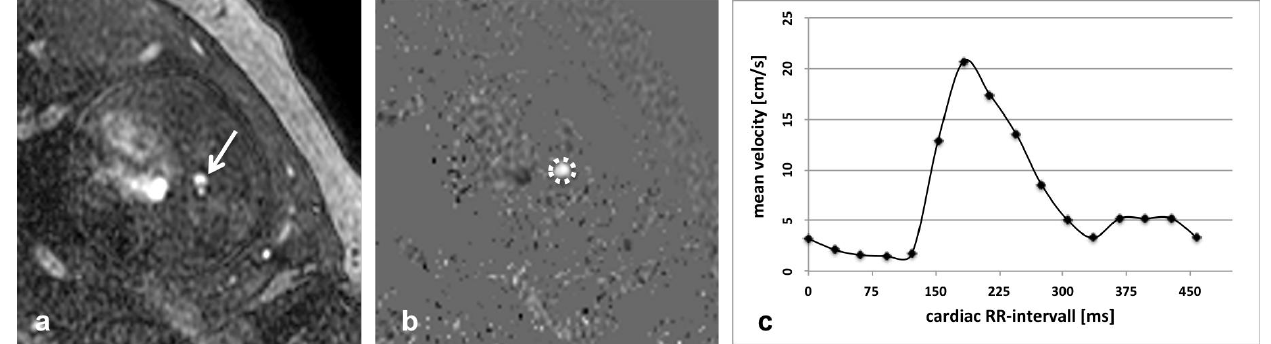
Figure 3. 2-D phase-contrast MR angiography (TR = 4.9 ms, TE = 3 ms, field of view = 250 mm, flip angle = 15°, slice thickness 5 mm, matrix size = 194 × 194 mm) using Doppler ultrasound gating at 1.5 Tesla for assessment of blood flow hemodynamics. Transversal orientation through the descending aorta (arrow in a ) with resulting magnitude image ( a ) and phase image ( b ). Blood flow hemodynamics are assessed by placement of a region of interest (ROI; dotted circle in b ) in the vessel lumen. Dynamic blood flow over the whole cardiac cycle is encoded by signal intensities within the ROI. ( c ) In this example of a late term fetus (gestational age: 30 + 4 weeks) resulting mean flow velocity illustrates typical arterial flow waveform over the cardiac